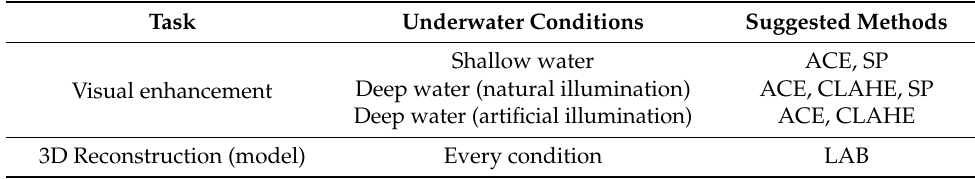
Table 13. Suggested methods according to different underwater conditions and tasks.